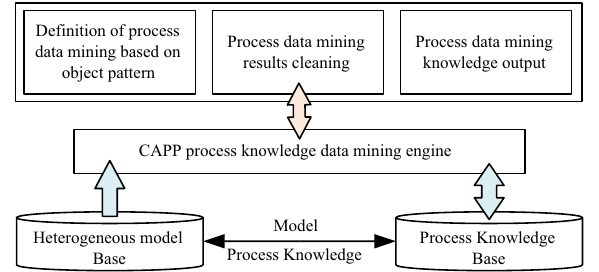
Figure 4. Process data mining method based on object